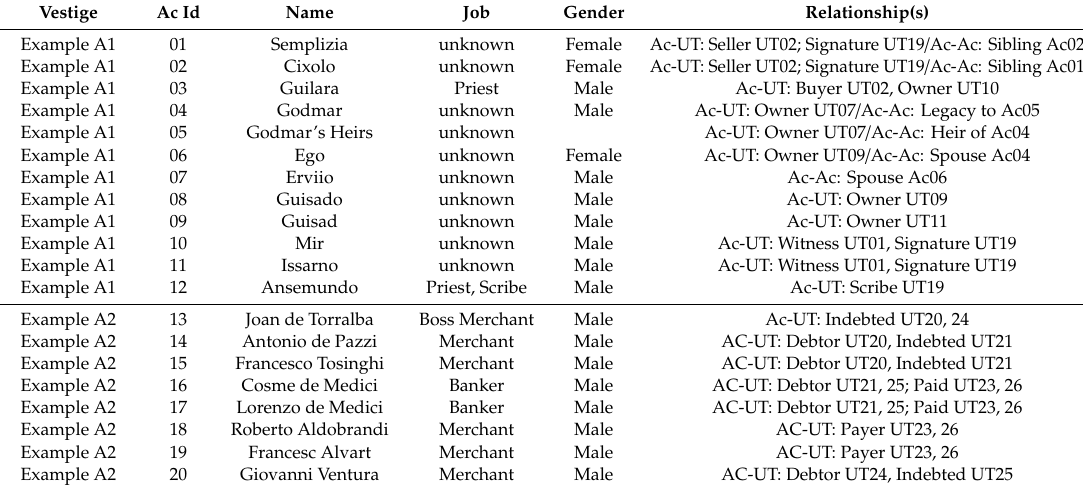
Table A2. Simplified Ac dataset gathered from Examples A1 and A2.